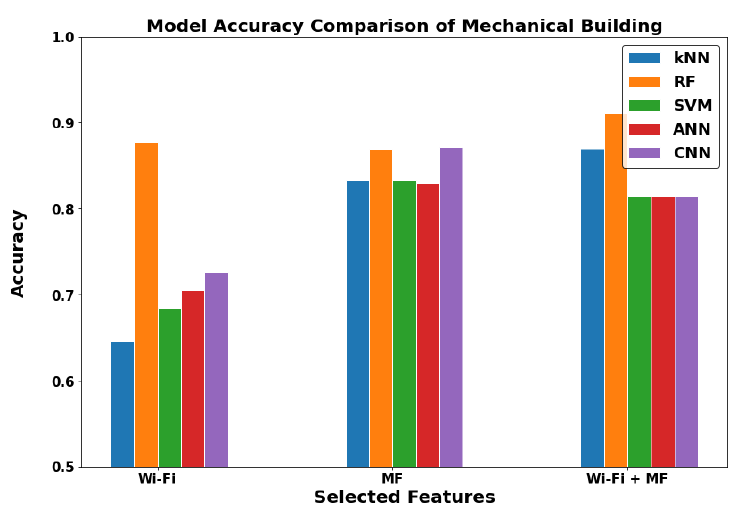
Figure 15. The models comparison in Communications department building (Outdoor).